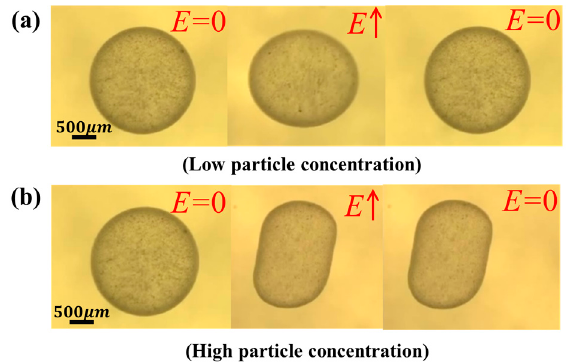
portions, each arrested at the equator ends of the droplet in the form of ‘caps’. Here, S > R ; SC system.